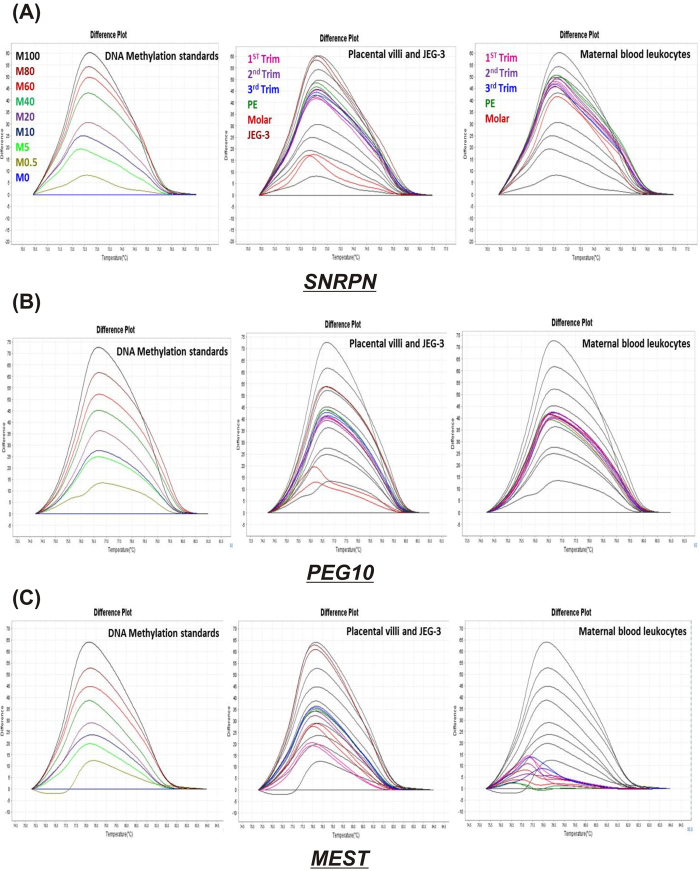
DNA methylation at DMRs of imprinting genes as predicted by HRM software.HRM difference plots for (A) SNRPN (B) PEG10 (C) MEST. Each representing three difference plots: first one for methylation standards in different colors (M100% - M0%, which stands for DNA methylation standards with 100 to 0% methylation) normalized to the 0%-methylated standard DNA, second and third difference plots for few selected samples from placental villous groups & JEG-3 cells and maternal leukocyte groups represented in different colors and methylated standard curve of M100 to 0% represented as black curves. Note: “Trim” stands for trimester.